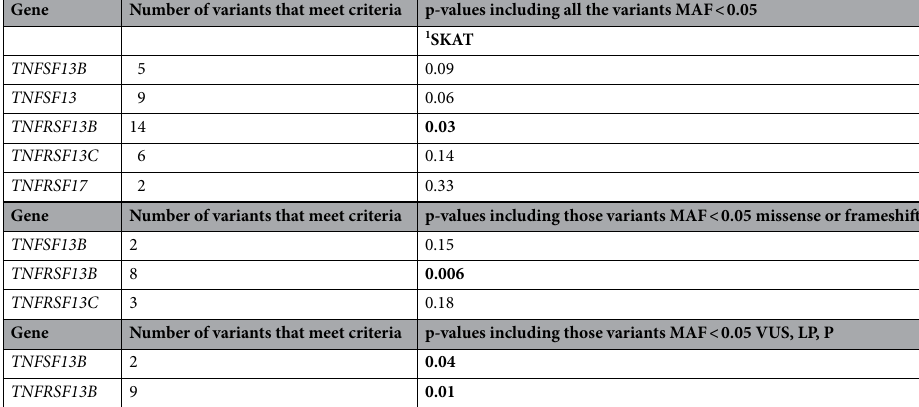
Gene Number of variants that meet criteria p-values including all the variants MAF < 0.05